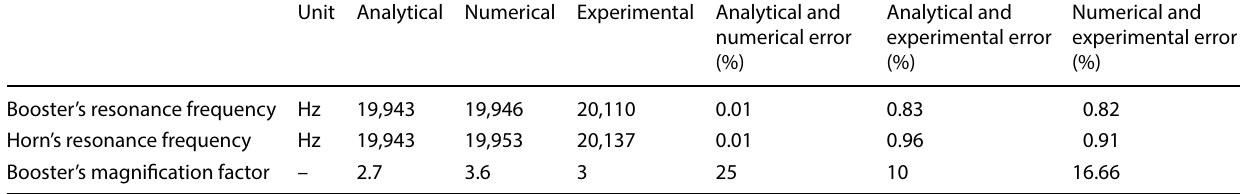
Table 6 Measured resonance frequency of the booster and the horn, magnification factor of the booster and comparisons between the results Unit Analytical Numerical Experimental Analytical and numerical error